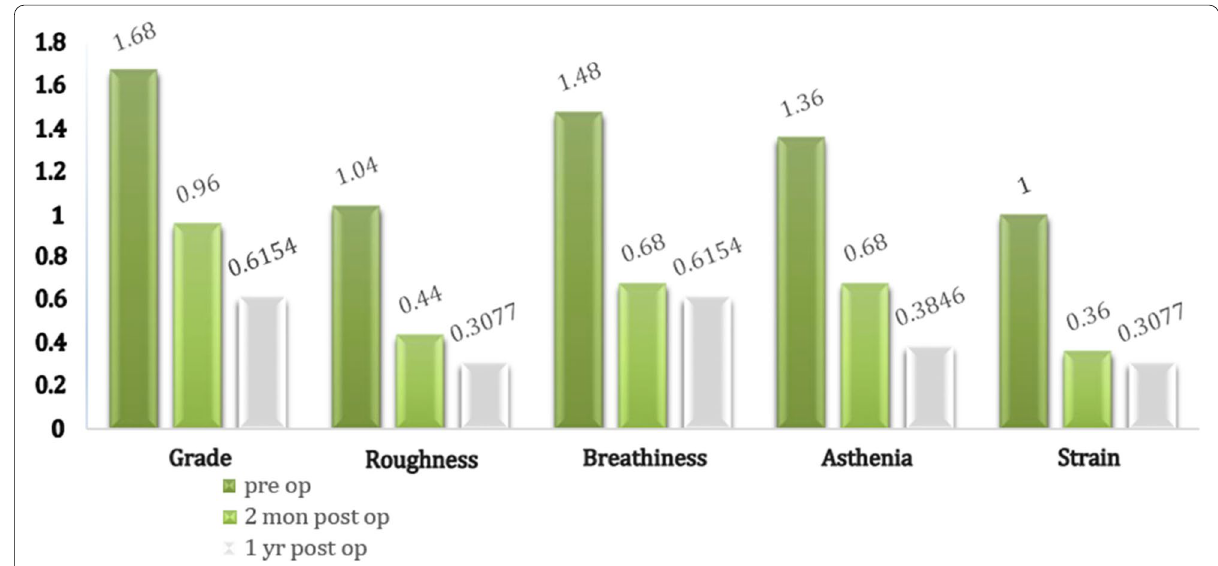
Fig. 2 GRBAS scale mean values before injection and 2 months and 1 year after injection.